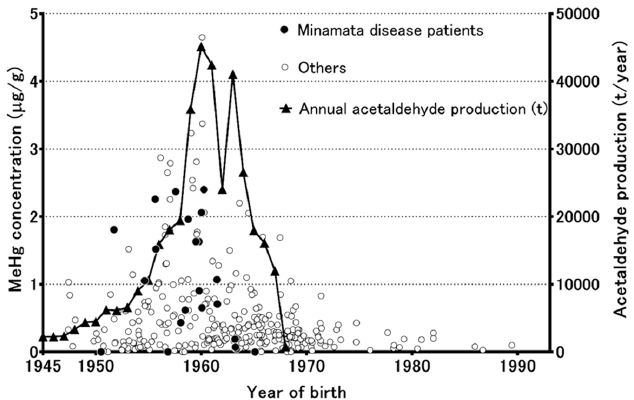
Figure 1. Individual methylmercury concentrations of preserved umbilical cords ( μ g/g dry weight) from the Minamata area and the amount of annual acetaldehyde production.